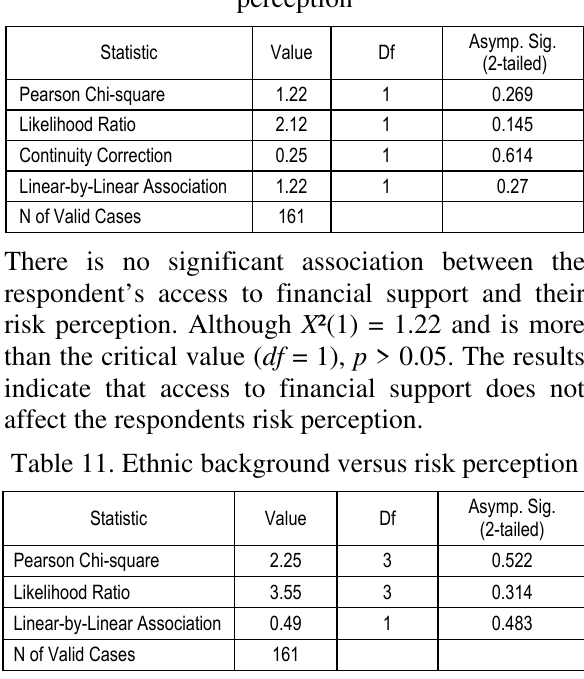
Table 10. Access to financial support versus risk